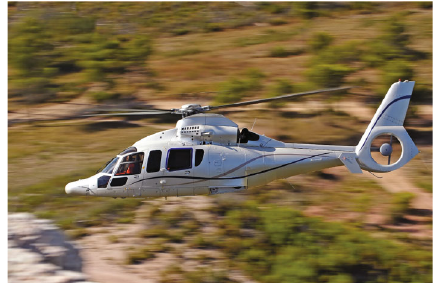
Figure 1: Airbus Helicopter H155 [18].